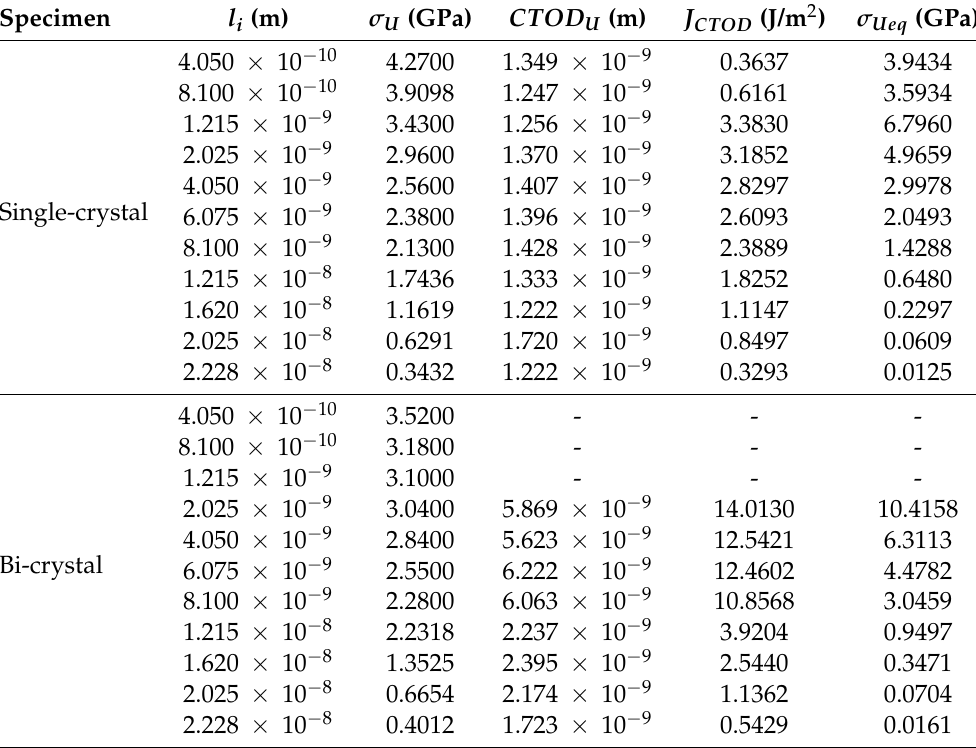
Table 1. Data used for estimating ¯ σ U and J C .